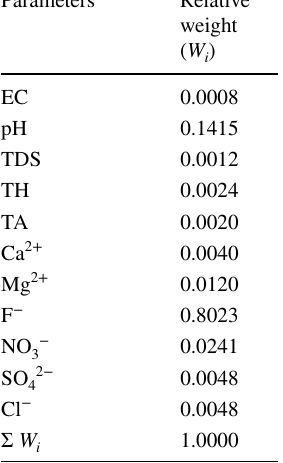
Table 3 Relative weight of chemical parameters for